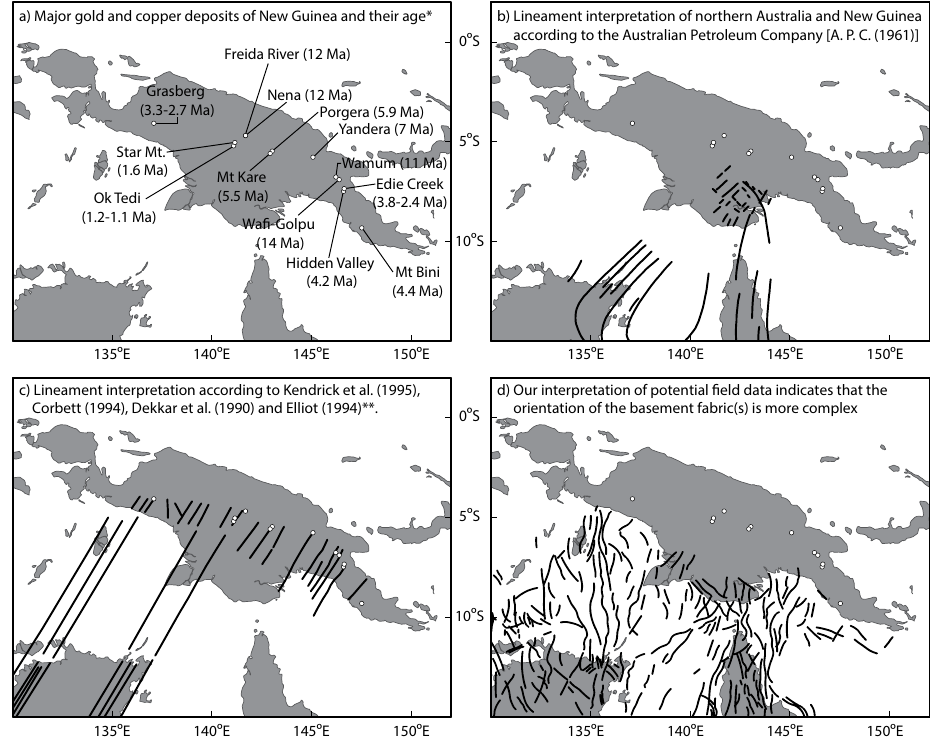
Fig. 1. Maps of northern Australia and New Guinea showing (a) the location of major gold and copper deposits and the age of mineralization; (b) the location of lineaments according to the Australian Petroleum Company (A. P. C., 1961), who suggested that the basement fabric of northern Australia persisted across the Arafura Sea and into southern Papua New Guinea; (c) the location of lineaments that were identified by different studies conducted along the length of New Guinea (Hill et al., 1991; Corbett et al., 1994; Dekker et al., 1994 and Kendrick et al., 1995). These interpretations assumed that NNE striking structures of the Australian mainland could be extrapolated across the Arafura Sea and into New Guinea (in this case the structures that are shown here for northern Australia were proposed by Elliot (1994)). (d) However, our interpretation of magnetic data (Milligan (2010): Magnetic Map of Australia, 5th Edition) and gravity data (Pavlis et al., 2008, 2013; this paper) indicates that the orientation of the basement fabric is much more complex than previous workers proposed. * Mineralization ages were taking from the compilation of Garwin et al. (2005). ** Image was adapted from a figure presented in Hill et al.